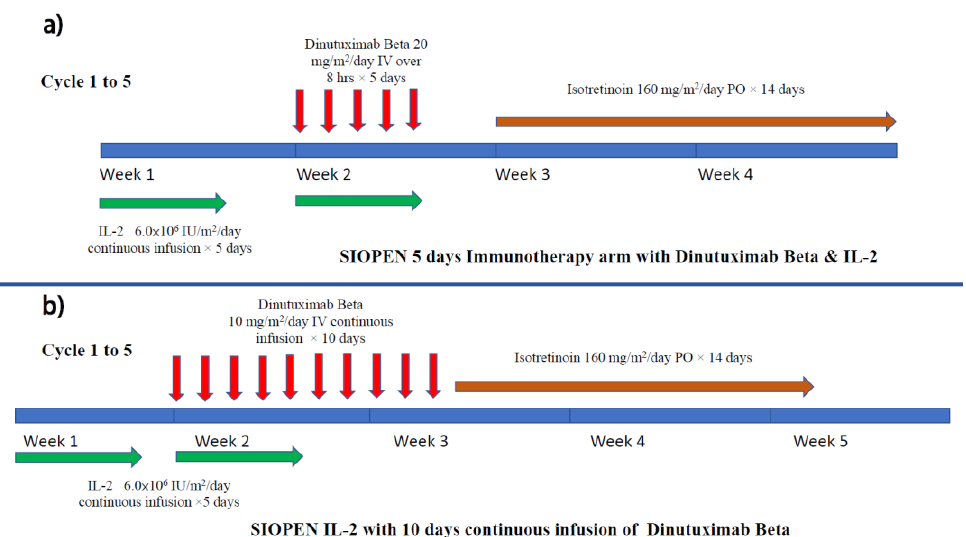
Figure 4. Treatment schema of ( a ) SIOPEN maintenance immunotherapy (dinutuximab beta) with IL-2 and ( b ) SIOPEN continuous infusion immunotherapy with IL-2 for relapsed